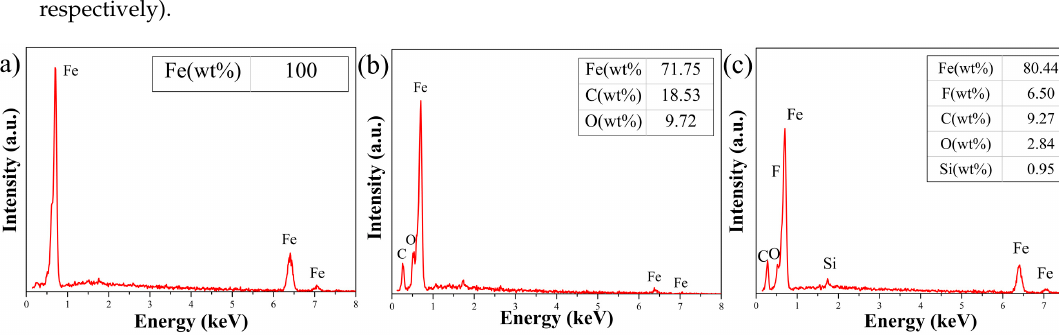
Figure 2. EDS of polished Q235 carbon steel surface ( a ), structured Q235 carbon steel surface ( b ), and structured surface after modification of PFTEOS ( c ).